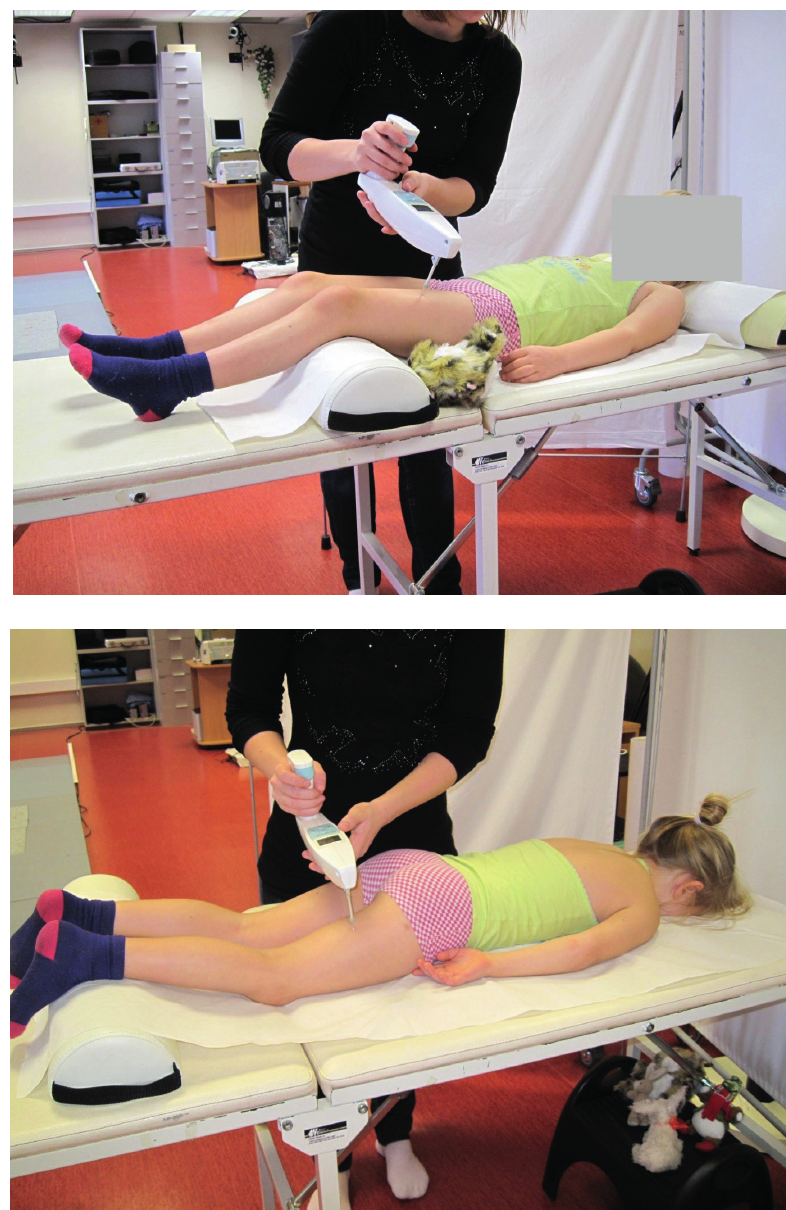
Figure 1A. Subject in a supported supine position for measuring TA, RF and BB muscles